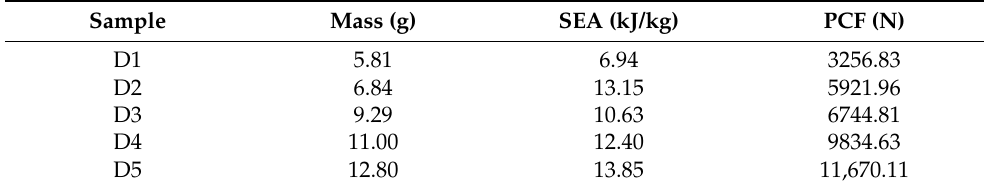
Figure 19. ( a ) Effect of different t on force; ( b ) effect of different t on energy; ( c ) effect of different t on stress–strain curve; ( d ) effect of different t on peak crushing force and specific absorption energy. Table 5. Numerical results of specimens with different sizes of t